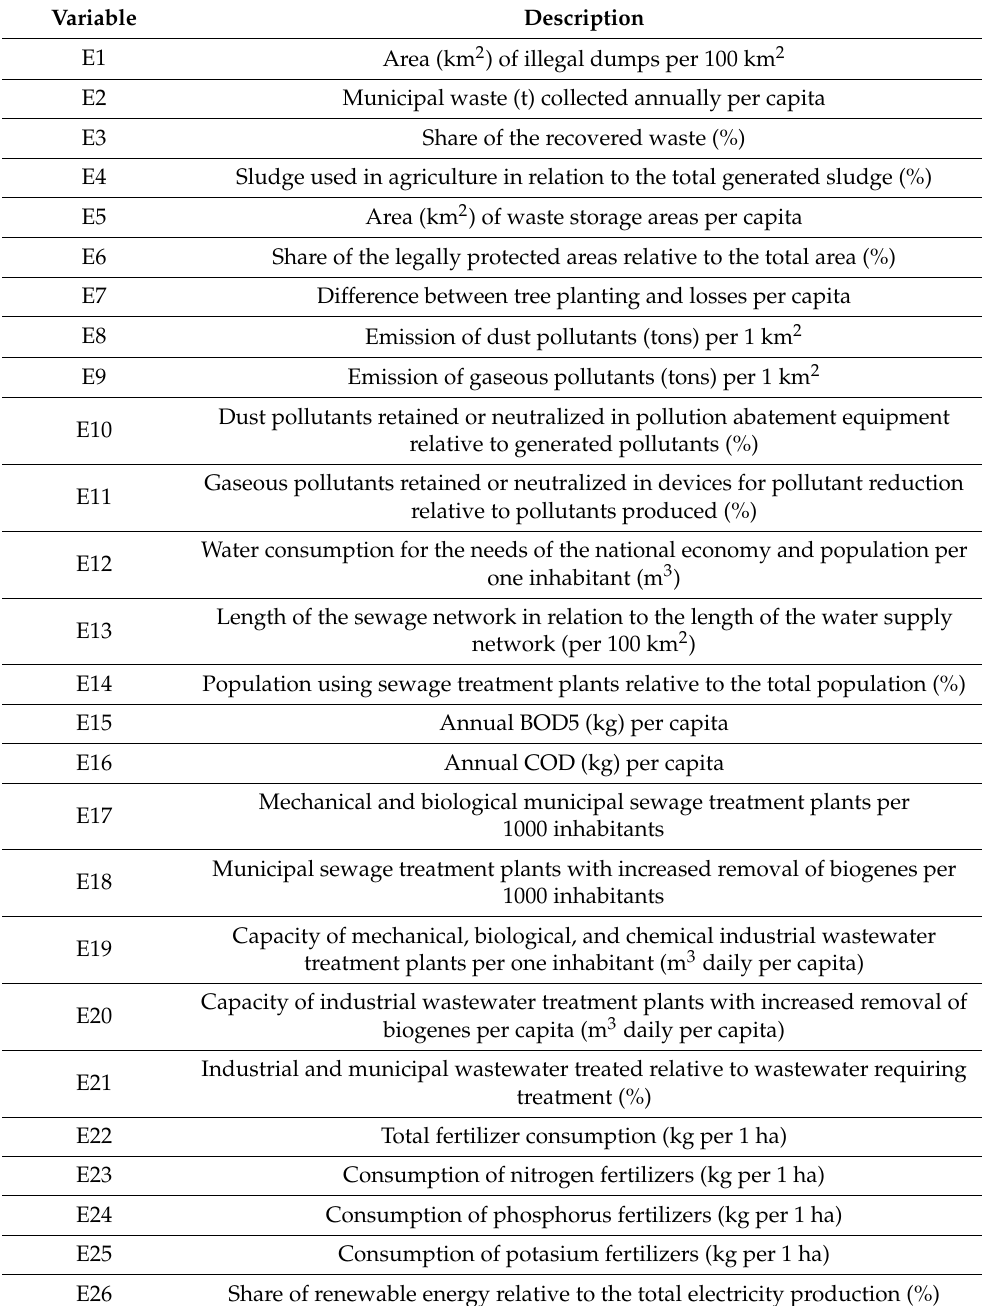
Table 2. Variables describing the environmental